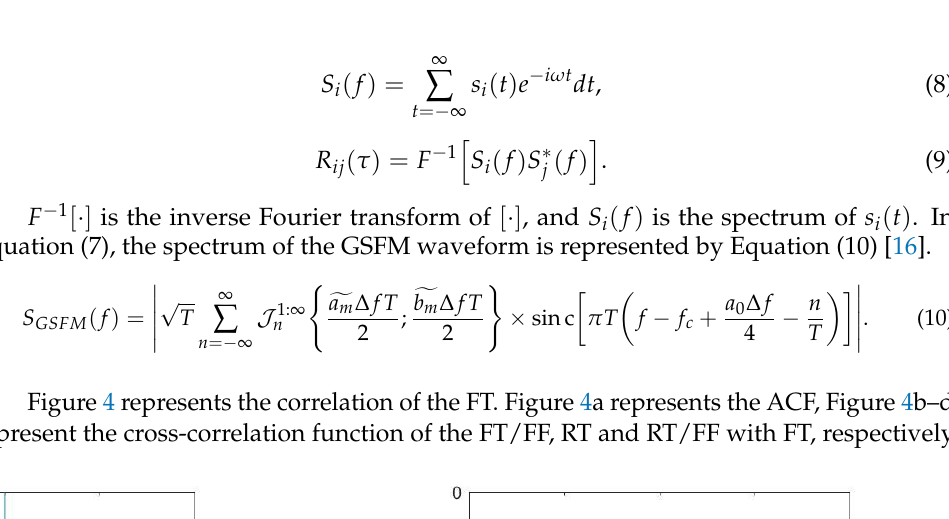
( d ) Figure 3. ( a ) Auto-AF of the FT, ( b ) cross-AF of the FT/FF and FT, ( c ) cross-AF of the RT and FT and ( d ) cross-AF of the RT/FF and FT.